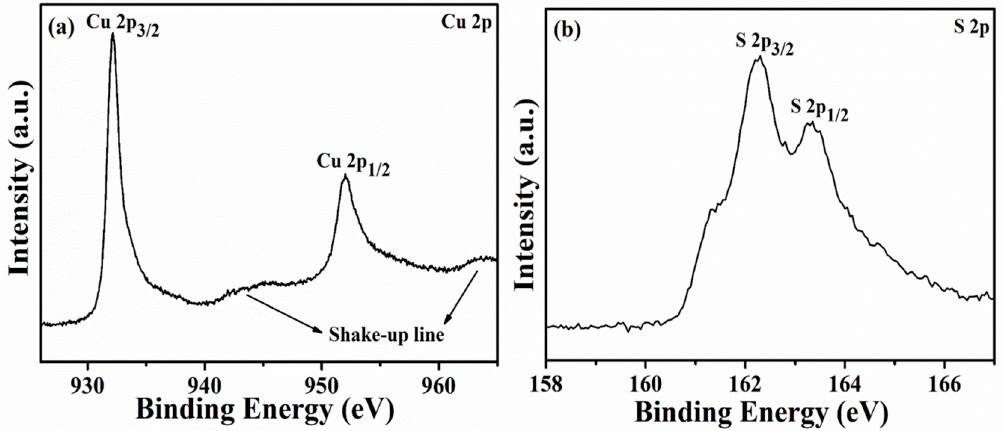
Figure 3. XPS spectra of CuS: ( a ) Cu 2p, ( b ) S 2p.